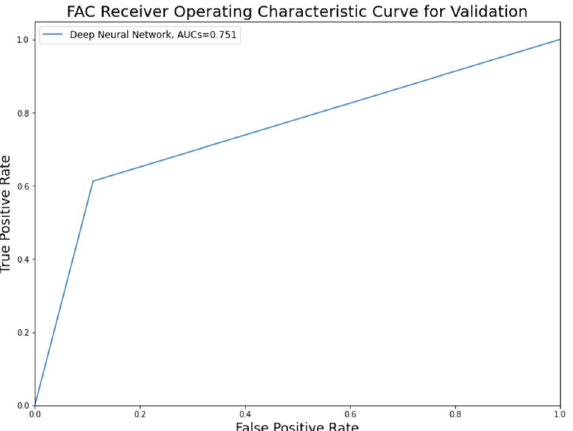
Figure 1. Functional ambulation category (FAC) receiver operating characteristic curve and area under the curve for data